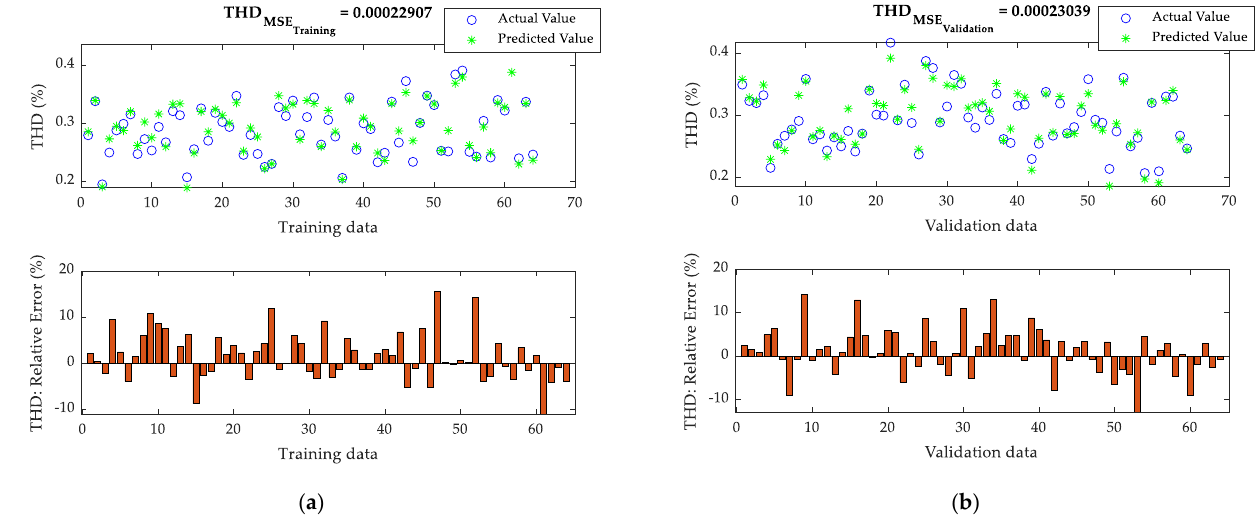
Figure 14. Results of the tuned FIS in the first step for THD: ( a ) training data; ( b ) validation data.